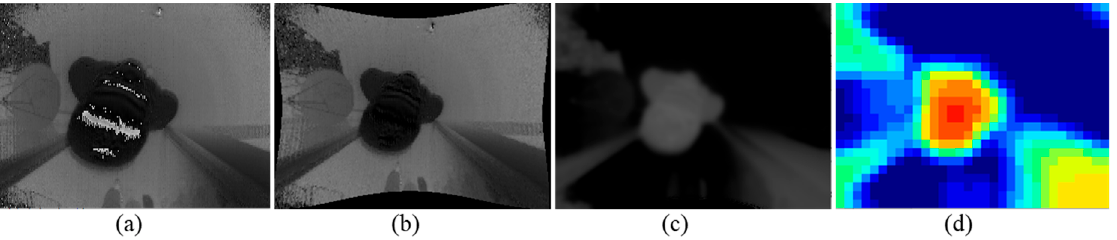
Figure 1. Distortion rectification and Gaussian filtering. ( a ) Raw depth image with distortion and overexposure; ( b ) corrected and rectified depth image. The objects in the scene are adjusted to the correct size. The overexposed pixel values have been corrected; ( c ) depth image with pixel values converted to the ground plane; ( d ) Visualization of pooled image. The red area symbolizes proximity to the TOF camera. Blue pixels mean far distance from the TOF camera.